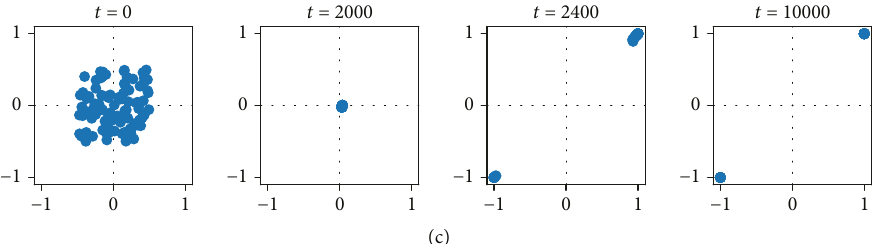
Figure 14: Exemplar spatiotemporal dynamics of agent opinion coordinates with K = 2 and S = 0 5 for σ ∈ 0 0,0 08,0 2 . There are three regimes. In the fi rst, without noise, every simulation ends in centrist consensus (top row). In the presence of noise with σ = 0 08 , agents fi nd extremist consensus; in this trial, agents found consensus around the point − 1, − 1 . The third regime is the high polarization regime at the highest level of communication noise we tested, σ = 0 2 . In this regime, agents split into opposing camps, led by fi rst-mover